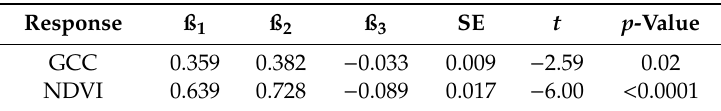
Figure 7. GCC ( A – D ) and NDVI ( E – H ) imagery calculated from UAV imagery that corresponds to field transects. Alnus transect 1 burned in 1984 ( A , E ). BP transect 2 burned in 1983 ( B , F ). CN transect 1 burned in 2001 ( C , G ). CN transect 2 burned in 2001 ( D , H ). Plot locations are labeled with negative values indicating field plots on the unburned portion of the transects and positive values indicating distance into the burn in meters. Edges of fires were identified prior to the field campaign with satellite imagery. Table 6. A Welch t -test for unequal variance was performed to test for a di ff erence in the means of GCC and NDVI (using 10-m bu ff er radius) between burned and unburned areas. For each model, we report the response variable, estimated mean of burned (ß 1 ), estimated mean of unburned (ß 2 ), estimated di ff erence in means (ß 3 ), standard error for the di ff erence in means (SE), the test statistic value ( t ), and p -value. Data are visualized in Figure